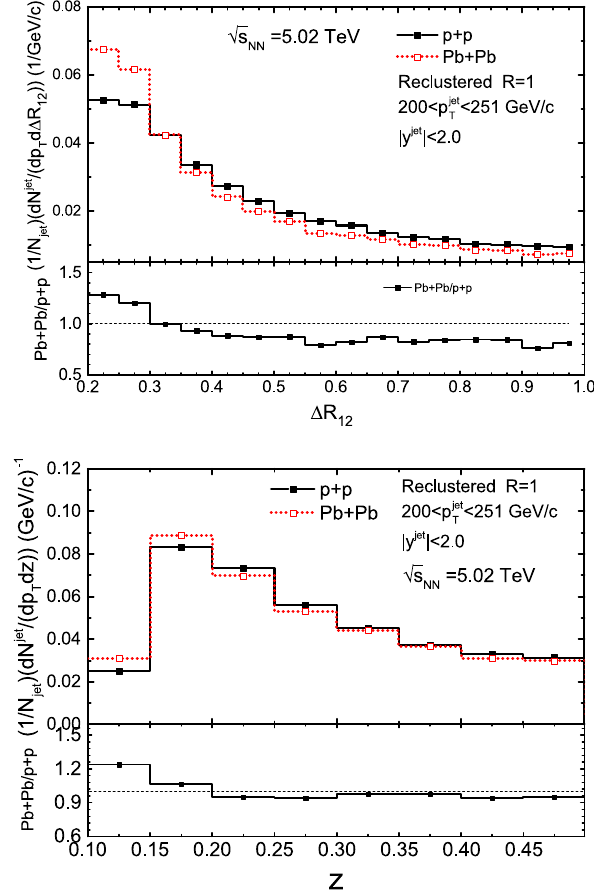
√ Fig. 6 Normalized LR jet distributions as a function of the splitting < d 12 with 200 < p jet T scale (cid:2) R 12 in p + p and Pb + Pb collisions as well as its modification due to jet-medium interactions (top panel). Normalized distributions calculated as a function of the splitting variable z = p min p + p and Pb + Pb collisions as well as its modification in Pb + Pb √ collisions relative to p + p collisions d 12 spectrum in Pb + Pb